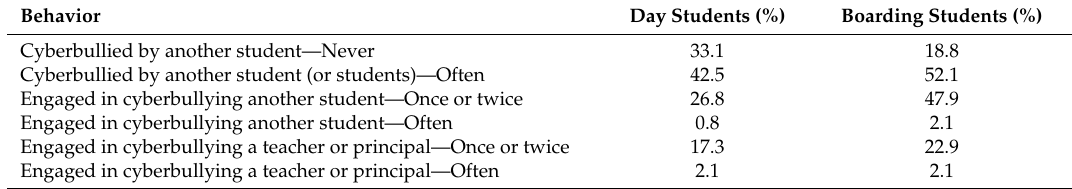
Table 1. Comparison of day and boarding students’ involvement with